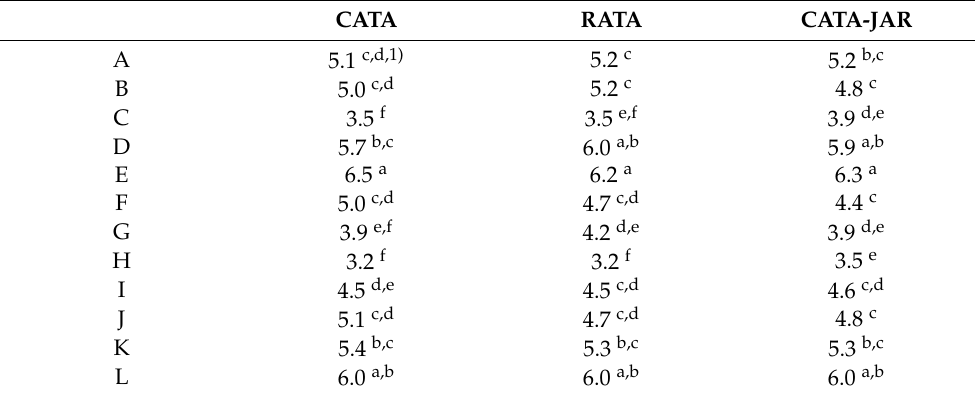
Table 2. Overall liking of 12 yakjus obtained from the consumers for each of the